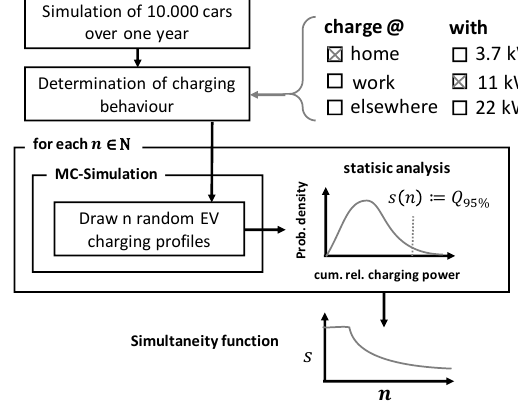
Fig. 3. Process for the determination of simultaneity